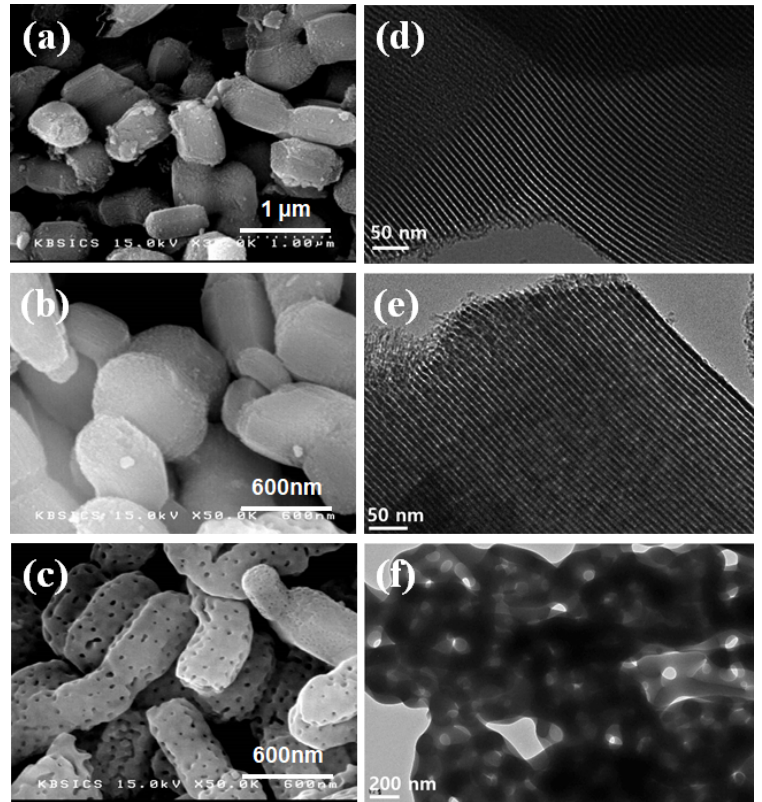
Figure 5. SEM ( a – c ) and TEM images ( d – f ) of ( a , d ) SBA15-Na-40-500, ( b , e ) SBA15-Na-40-600 and (c,f) SBA15-Na-40-650 after thermal treatment with different temperatures (500 – 650 °C) using Si/Na = 40.